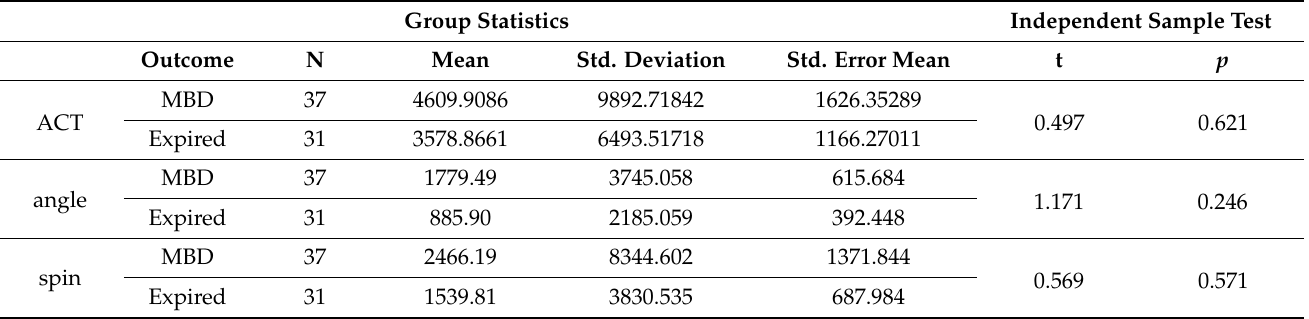
Table 2. Statistical difference in ACT, angle, and spin values for MBD and expired in 12 h data. Group Statistics